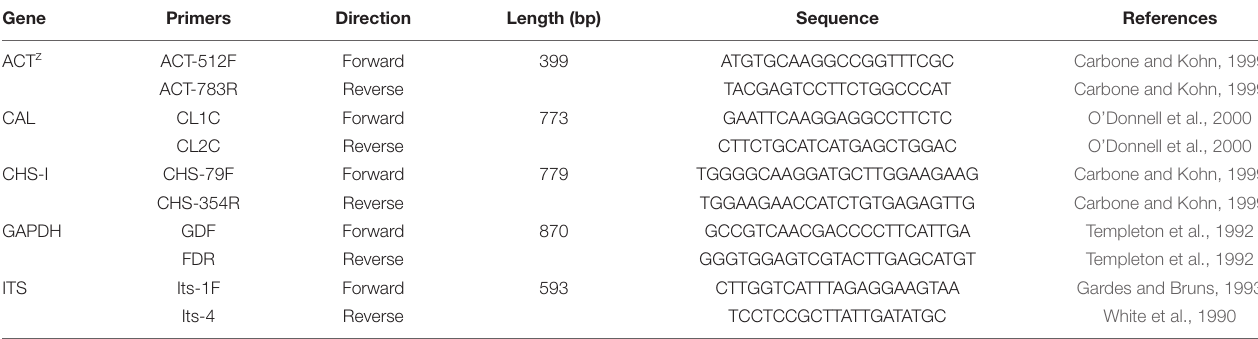
TABLE 1 | Primers used in this study with sequences and